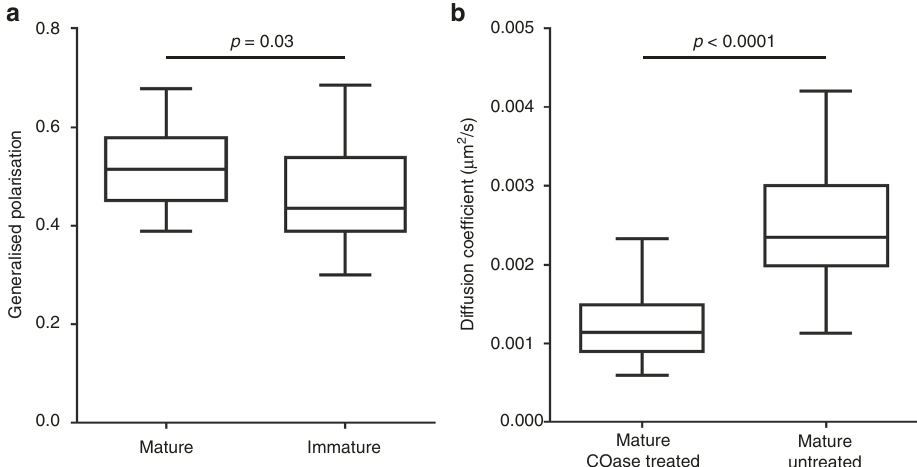
Fig. 5 Analysis of HIV-1 lipid membrane properties by C-Laurdan staining and after cholesterol depletion. a Median values of the generalised polarisation (GP) parameters were determined from pixels of spectral images corresponding to C-Laurdan and mCherry.Vpr labelled mature and immature virus particles. Results represent measurements from 40 particles each from two independent virus preparations and are shown in a box (IQR) and whisker (min/max) plot. The statistical signi fi cance was assessed using Wilcoxon rank-sum test. b Median Env diffusion coef fi cient (D) of cholesterol oxidase (COase) treated HIV-1 was determined by sSTED-FCS measurements of 50 mature particles each from two independent virus preparations. Results are shown in a box (IQR) and whisker (min/max) plot and the statistical signi fi cance was assessed by Wilcoxon rank-sum